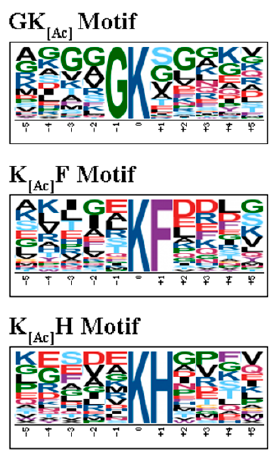
Figure 8. Motif analysis of all identified K Ac acetylated sites in PRU strain. Sequence logo representation of significantly enriched acetylation site motifs for ±5 amino acids around the lysine acetylation sites.